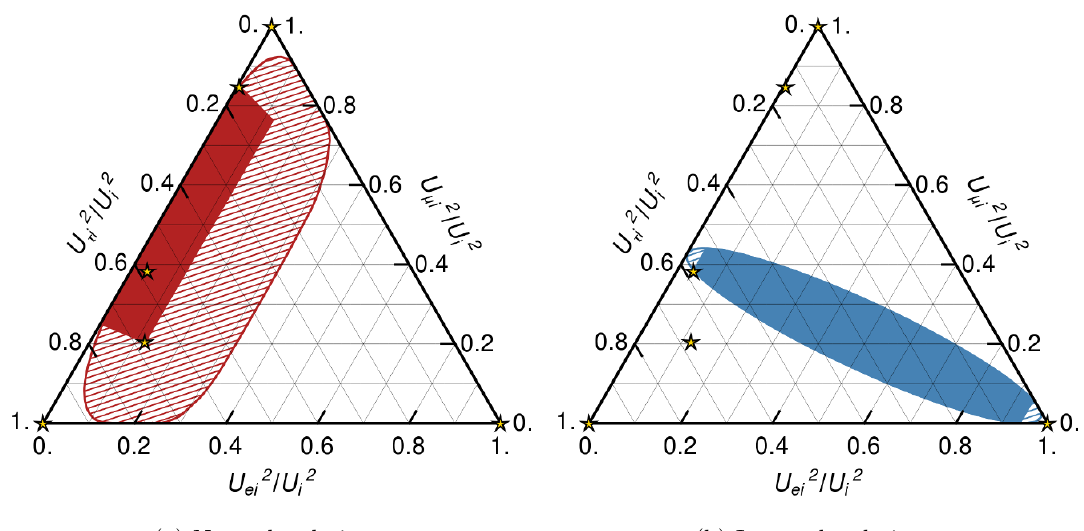
(a) Normal ordering. (b) Inverted ordering. Figure 1. Allowed range of U 2 =U 2 in the n = 2 model for arbitrary parameter choices (hashed a region) and in the symmetric limit ((cid:12)lled region) for normal ordering in Panel (a) and inverted ordering in Panel (b) of light neutrino masses. For an experiment with the sensitivity of NA62, the minimal model with n = 2 predicts the U 2 =U 2 to lie within the (cid:12)lled areas. Mixing patterns in the ai i extended hashed regions can only be made consistent with light neutrino oscillation data for total U 2 (cid:2) M i = GeV < 10 (cid:0) 11 , cf. (cid:12)gure 2. The stars mark the benchmark scenarios given in table 3a. i